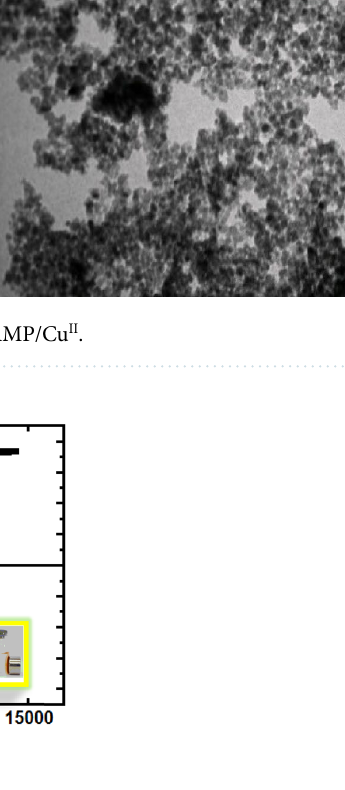
Figure 6. Magnetization loops of FNAOSiPAMP/Cu II .